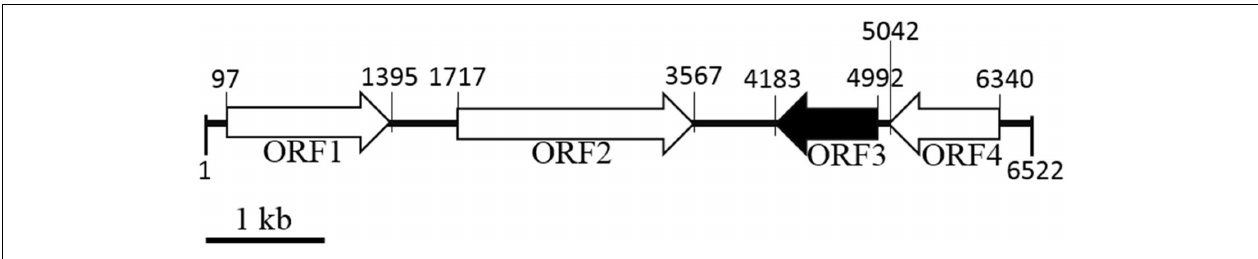
FIGURE 1 | Arrangement of predicted open reading frames on the original genomic clone pUC118No.1. The scale represents a 1-kb length of nucleotides.